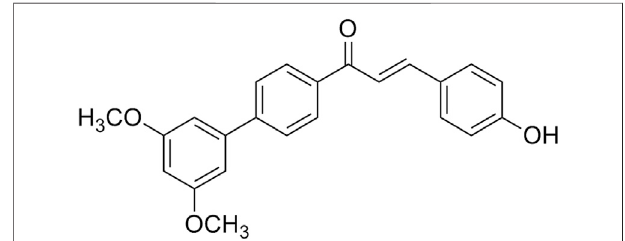
FIGURE 1 | The structure of Cur20 (1 — (3 ′ , 5 ′ - dimethoxy — [1, 1 ′ — yl) biphenyl] — 4 – 3 — (4 — hydroxyphenyl) prop — 2 — en — 1 —